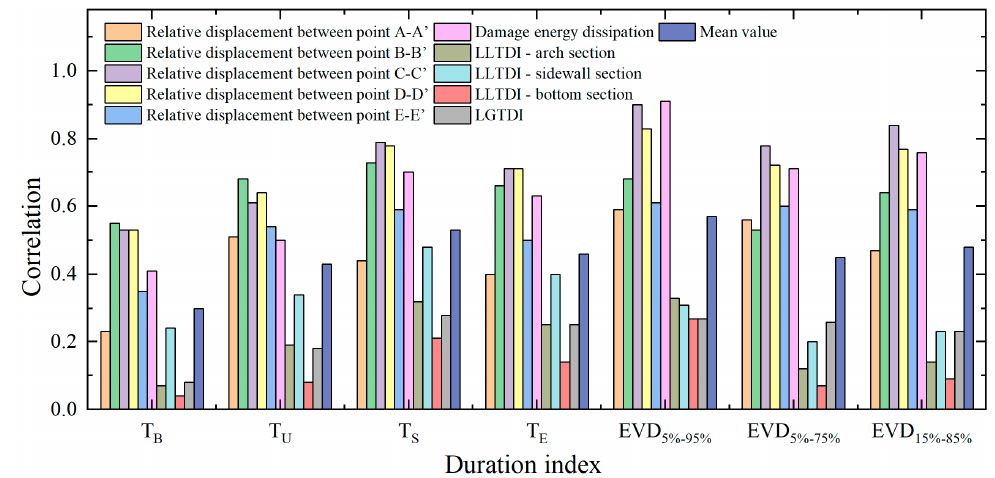
Figure 12. The correlation coefficient between duration index and numerical results of the hydraulic arched tunnels.